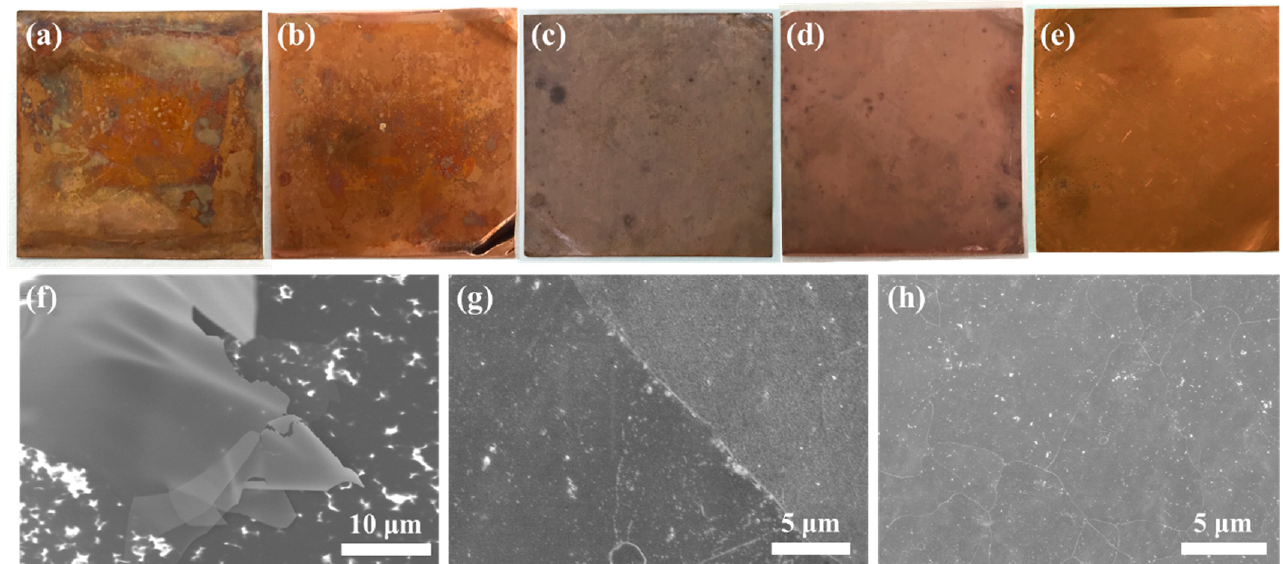
Figure 5. ( a – e ): Optical photos of bare copper foil ( a ), BCN ( b ), BCN-BCN ( c ), BCN-Gr ( d ), and BCN/Gr ( e ) samples after 8 h salt spray testing (sample size: 2 cm × 2 cm); ( f – h ) SEM images of BCN ( f ), BCN-Gr ( g ), and BCN/Gr ( h ) samples after 8 h salt spray testing.